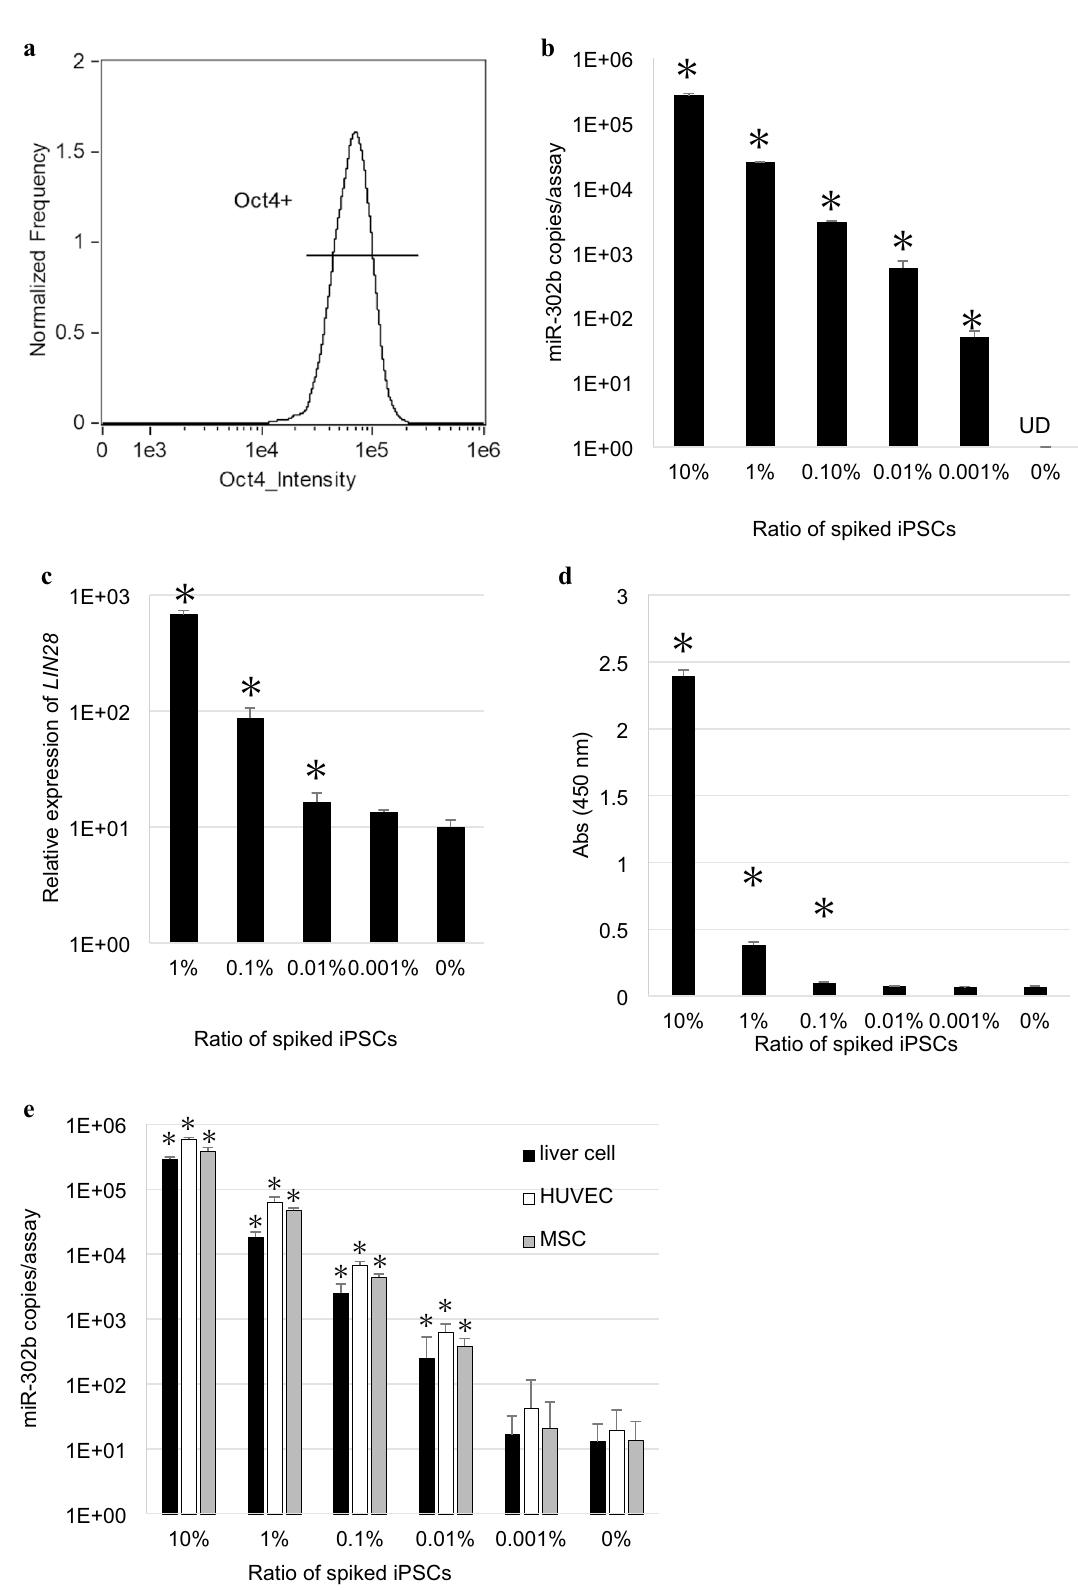
Figure 6. Sensitivity of detecting undifferentiated cells by measuring miR-302b in culture supernatant was 0.001%. ( a ) Oct4-positive rate of iPSCs used to develop the residual undifferentiated cell model was found to be 98.2%. ( b ) The detection sensitivity of miR-302b in the culture supernatant, ( c ) LIN28 in the cells, and ( d ) Fuca1-2Galβ1-3GaINAc in the culture supernatant was compared in the same residual undifferentiated cell model in which 10 6 RPE cells were spiked with the appropriate number of iPSCs. ( e ) Detection sensitivity of undifferentiated cells measured by detecting miR-302b in the culture supernatant of liver cells, HUVECs, and MSCs. Error bar = + 3SD . UD: no miRNA detected. *p value < 0.01, compared with 0%, Student’s